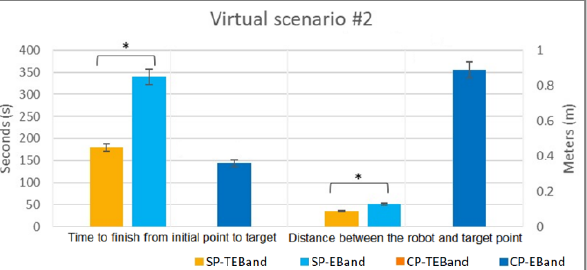
Figure 16. Comparison of time to finish and error among experimental groups using the warehouse scenario (* p < 0.05).